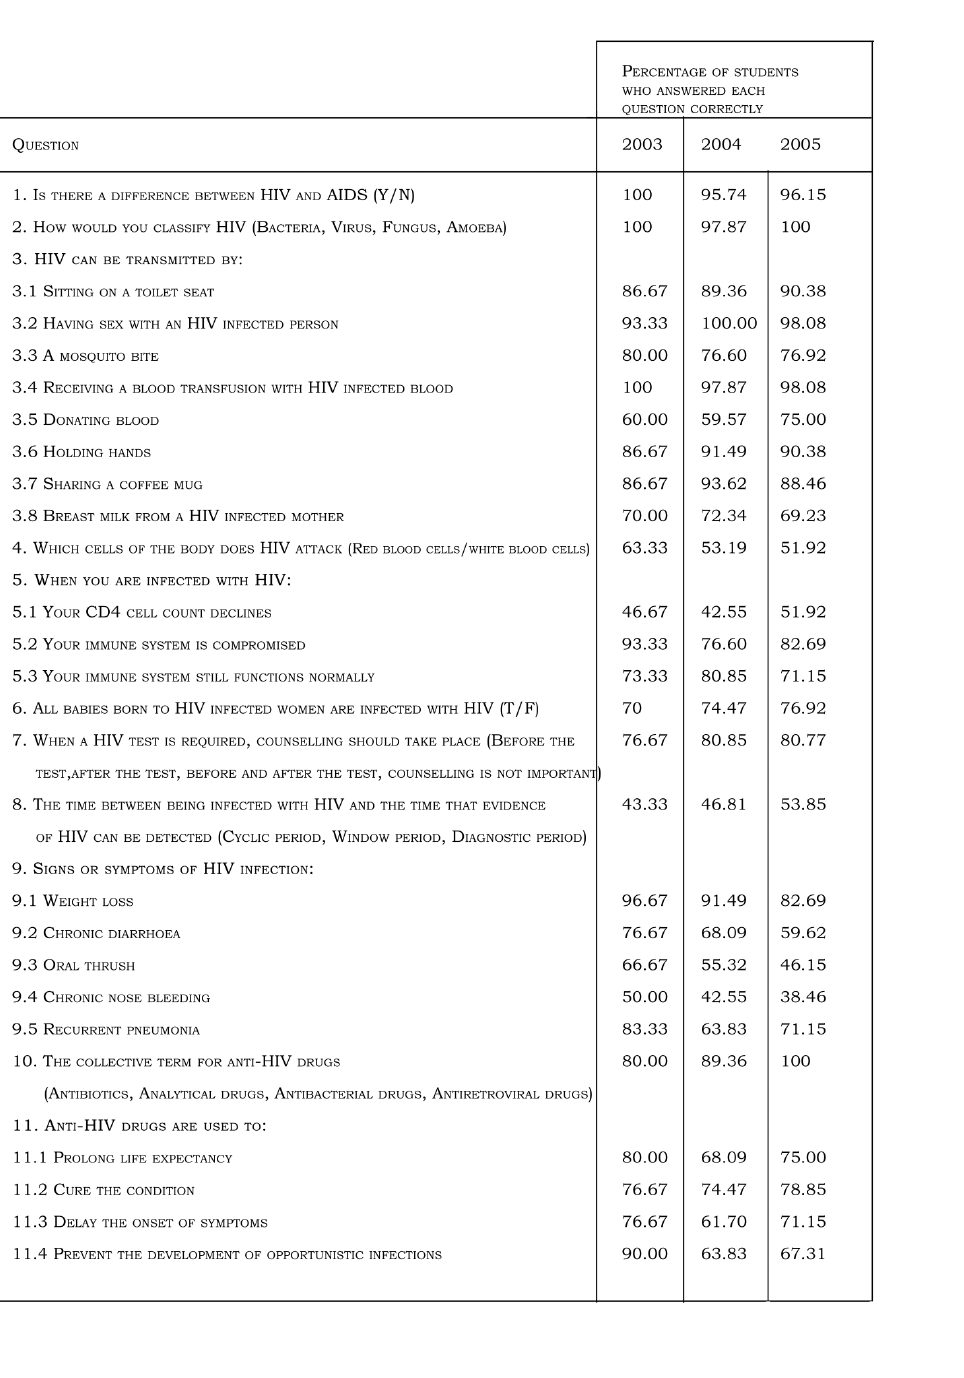
Bezuidenhout en Table 5: Percentage correct scores per question